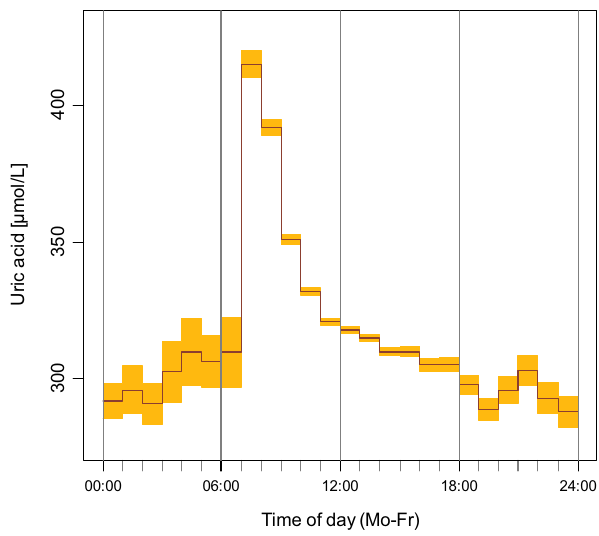
Figure 2: Diurnal variation of the uric acid concentration in heparinised plasma (ambulant patients, n=80,099). Daily observations are calculated during one week and the medians fromMondaytoFridayarepresented.Theyellowareasrepresentthe approximate 95% confidence limits based on the median absolute deviation (taken from ref. [27]).